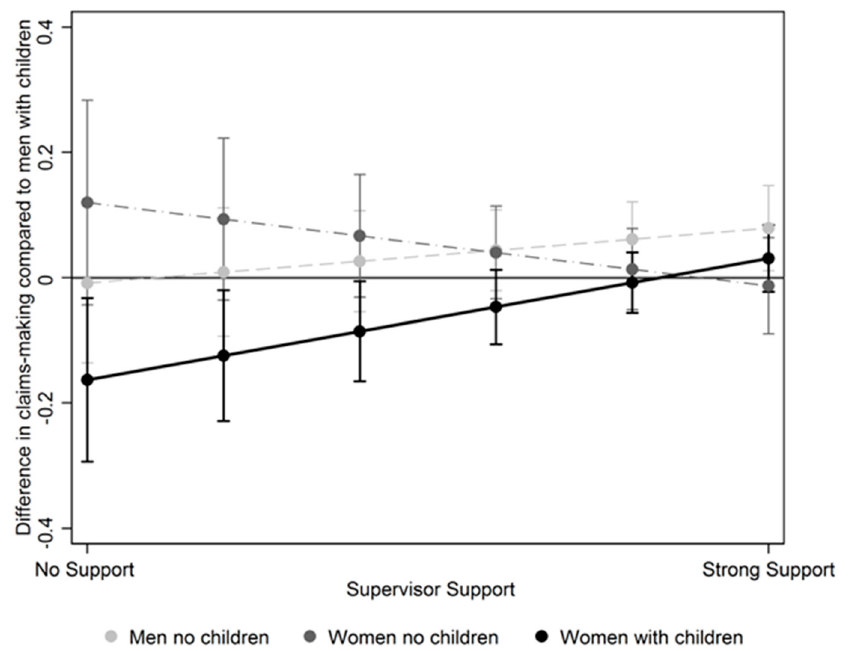
Figure 1. Gender differences in estimated values for claims-making according to supervisor support. Note: Based on results shown for model 1 in Table 5. The graph shows the interaction between supervisor support and family status; reference group = men with children; 90% confidence intervals, using Stata command contrast (StataCorp 2015).